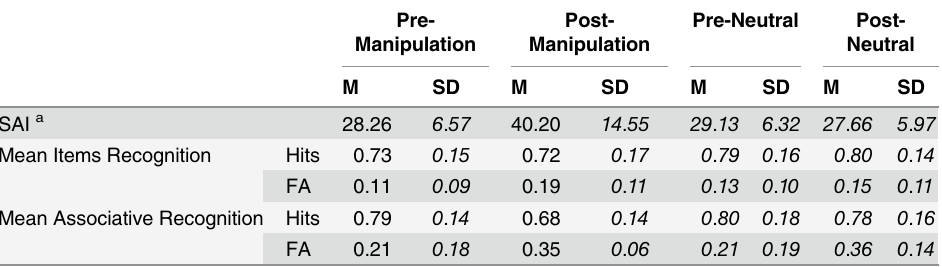
Table 1. Anxiety levels (SAI) and Memory Performance in the Pre and Post Manipulation Phases for the negative emotional arousal and Control Groups. Pre-